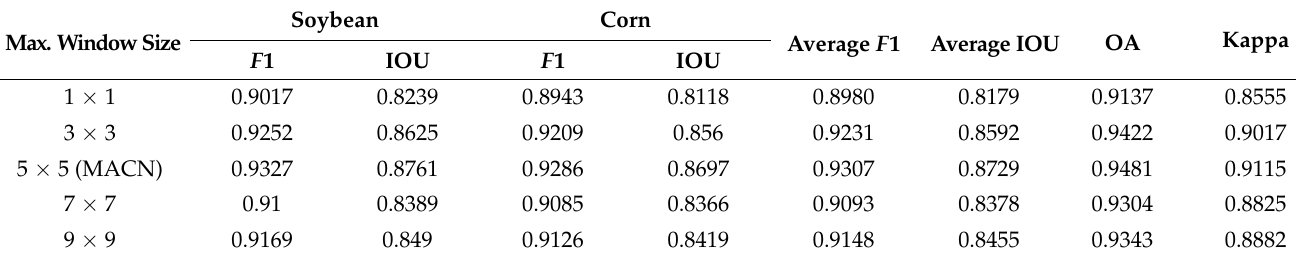
and boundary of the plot. Table 3. The crop-classification accuracy using the different window Table 3. The crop-classification accuracy using the different window sizes. Max. Window